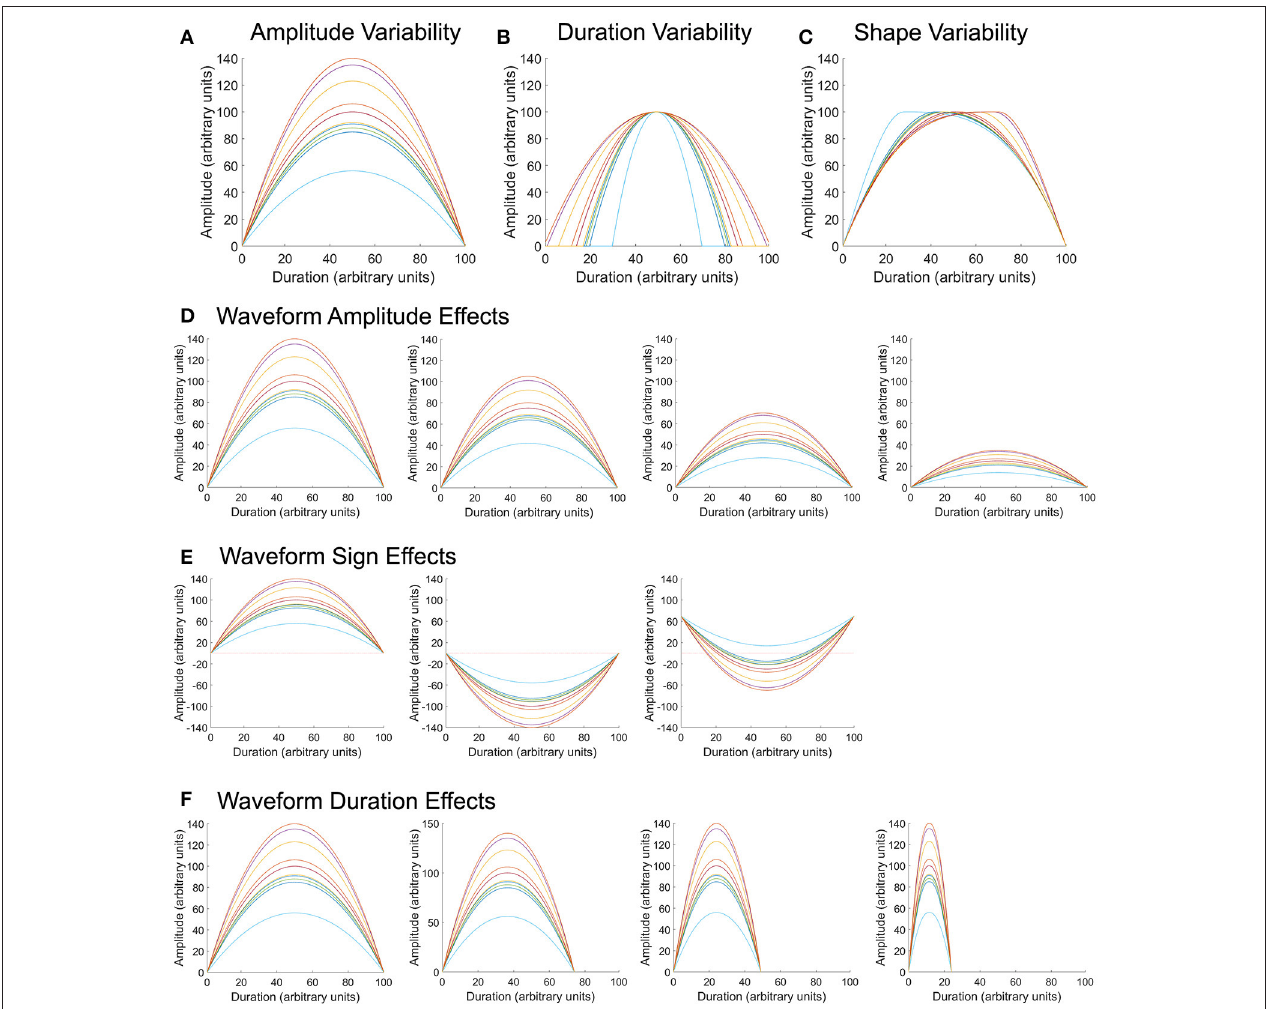
FIGURE 2 | Model waveforms and permutations. Parabolic waveforms were generated with random permutations in amplitude (A) , duration (B) , and shape (C) , or when in the waveform the maximum pressure occurred. Using the same amplitude permutations as in (A) , the overall mean of the waveform was varied to center around 100, 75, 50, or 25 arbitrary units (D) . Using the same amplitude permutations as in (A) , waveforms were modified such that all values were positive, all values were negative, or had a combination of positive and negative values (E) , to reflect properties of pharyngeal swallowing pressures. Finally, using the same amplitude permutations as in (A) , the overall duration of the waveform was varied to equal 100, 75, 50, and 25 arbitrary units (F)